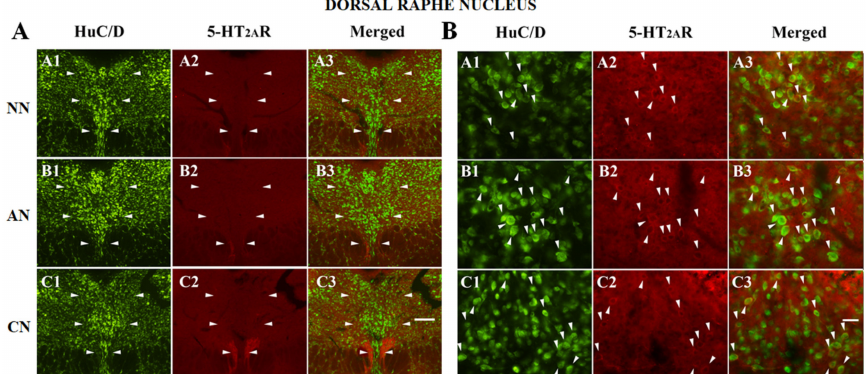
Figure 6. ( A ) Colocalization of the HuC / D with 5-HT 2A receptor (5-HT 2A R) in the dorsal raphe nucleus (DRN, bordered by arrowheads) of naïve nicotine (NN) (A1–A3), acute nicotine (AN) (B1–B3), and chronic nicotine (CN) (C1–C3) rats. Double immunofluorescence images showing HuC / D in green (left column pictures; A1, B1, and C1), 5-HT 2A R in red (middle column pictures; A2, B2, and C2), and colocalization of HuC / D with 5-HT 2A R in yellow (right column merging pictures; A3, B3, and C3). The immunoreactivity for the 5-HT 2A R is similar in the di ff erent groups. See text and Table 2 for explanations. Scale bar = 200 µ m in C3 (applies to A1–C3). ( B ) Colocalization of the HuC / D with 5-HT 2A R in the DRN of naive nicotine (A1–A3), acute nicotine (B1-B3), and chronic nicotine (C1-C3) rats. Double immunofluorescence images showing HuC / D in green (left column pictures; A1, B1, and C1), 5-HT 2A R in red (middle column pictures; A2, B2, and C2), and colocalization of HuC / D with 5-HT 2A R in yellow (right column merging pictures; A3, B3, and C3 arrowheads indicate double-labeled neurons). The proportion of 5-HT 2A R-immunoreactive neurons to the total neurons does not show significant di ff erences comparing the di ff erent groups. See text and Table 2 for explanations. Scale bar = 25 µ m in C3 (applies to